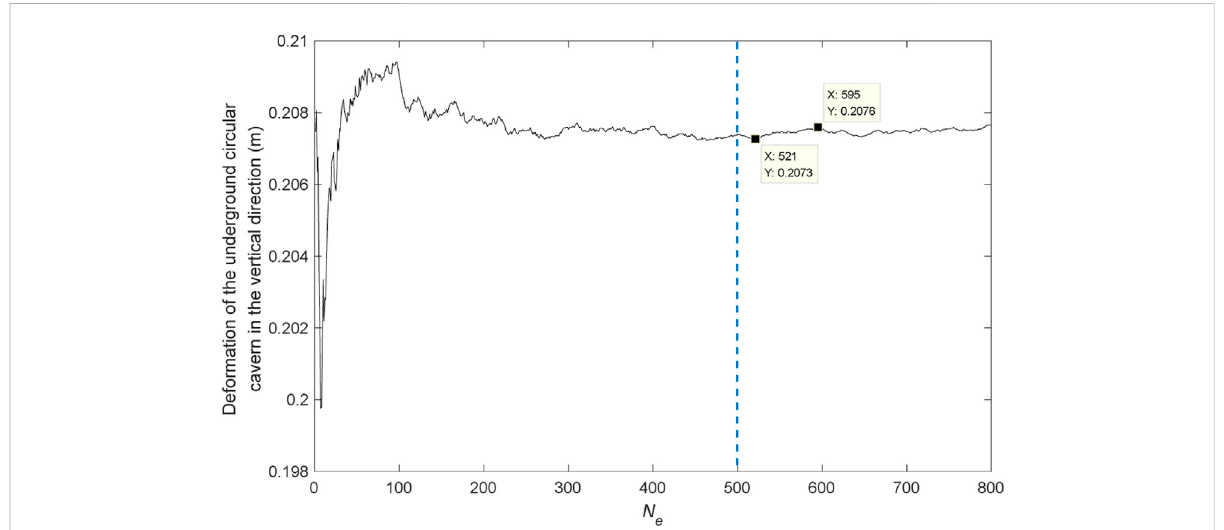
FIGURE 5 The change of vertical displacement with the number of simulation